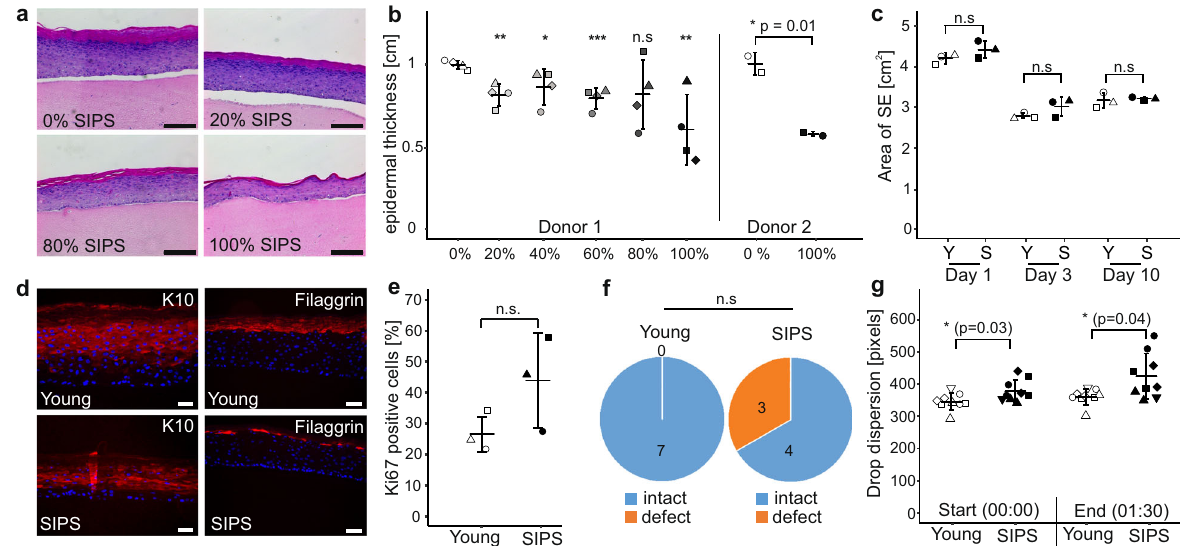
Fig. 2 Senescent fi broblasts induce hallmarks of skin aging in a 3D model. a , b Reduction of epidermal thickness in senoskin equivalents. Senoskin equivalents were built by gradually replacing proliferating with senescent fi broblasts. a Representative H&E sections of Donor 1 are shown. Scale bar 200 µm. b For each sample, relative thickness of the whole skin-equivalent section (5 – 7 images each) was measured using ImageJ, and mean thickness was calculated. On the left side of the graph, four independent replicates were counted for each condition in a blinded fashion; on the right side, the experiment was repeated twice in a second fi broblast donor. Statistical analysis was performed for Donor 1 using ANOVA and Dunnett post hoc test against control (0% SIPS). For Donor 2, unpaired t test was used. Error bars indicate SD. n.s